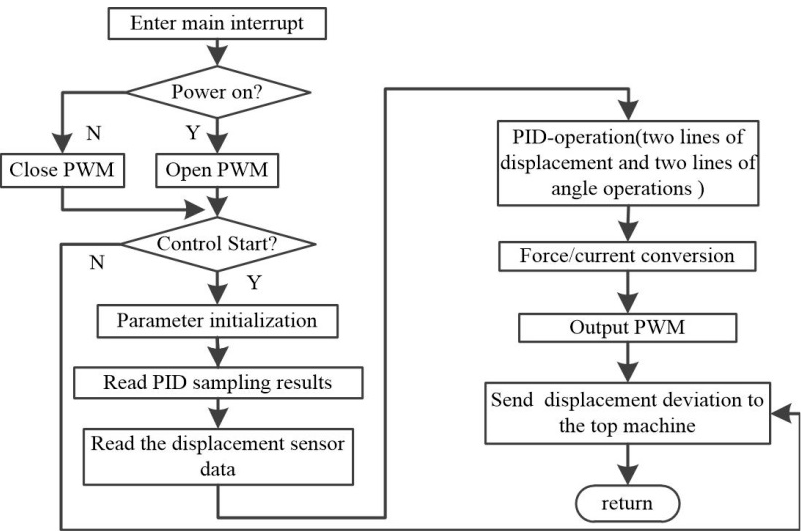
Figure 9. Program flow chart.